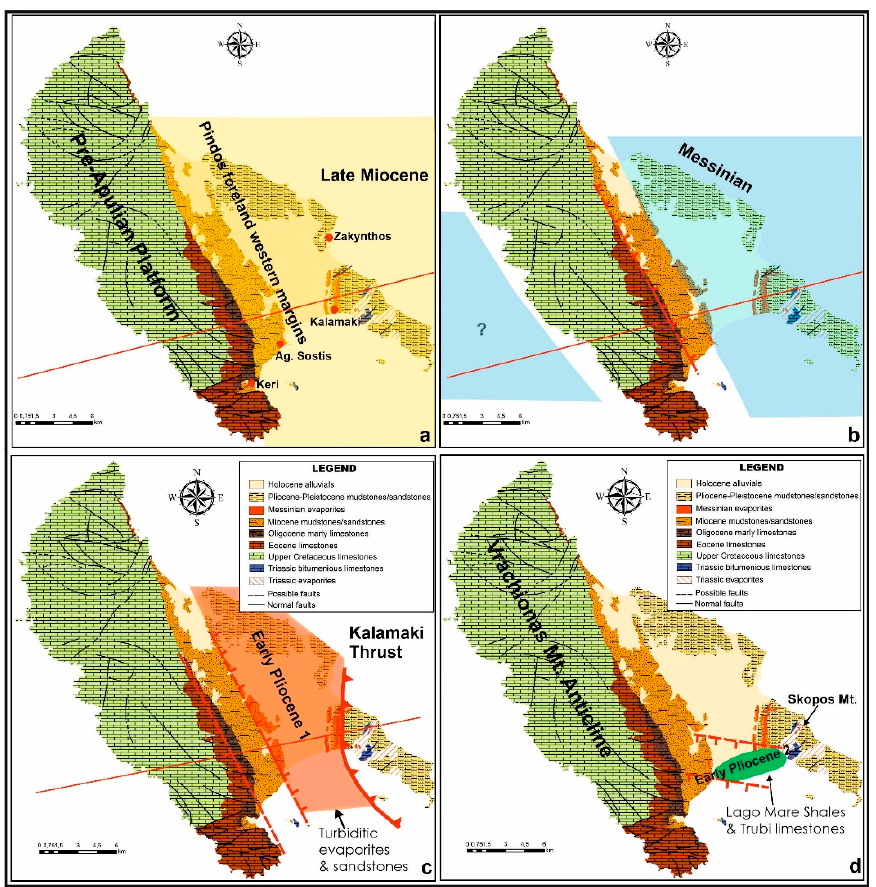
Figure 11. Paleogeographic maps showing in four stages the distribution of the sediments into the existing basins. ( a ) During Late Miocene, as the western part of the Pindos foreland, ( b ) during the Messinian, when the whole basin was desiccated, ( c ) during Early Pliocene, when the uplifted Messinian evaporites slid or eroded and resedimented into the Kalamaki Foreland (stage 1), ( d ) during Early Pliocene (stage 2), when the basin was restricted southwards, and Lago Mare and Trubi limestones were deposited.